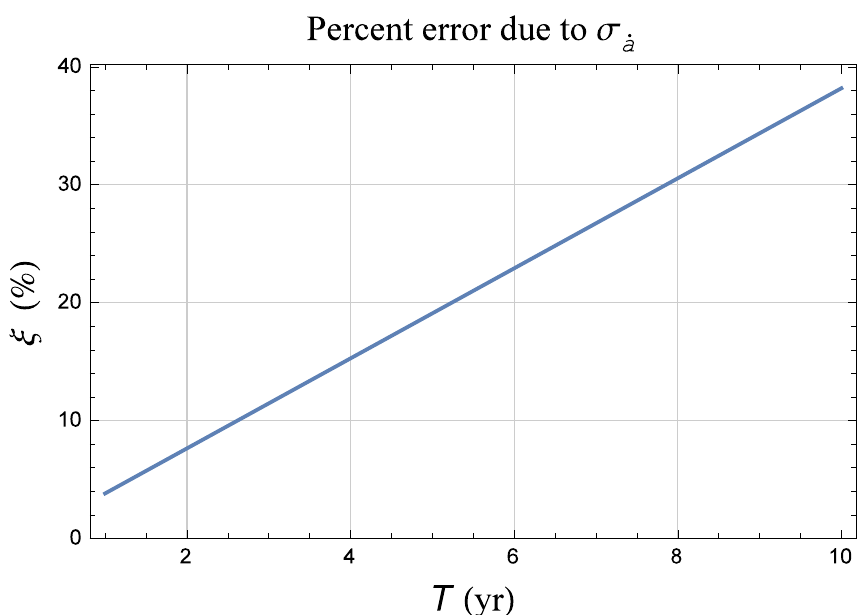
Figure A4. Percent systematic error ξ in the total L + CL Lense–Thirring node shift due to the uncertainties in the secular decays of the semimajor axes of L and CL calculated as a function of the data analysis time span T with Equations (22) and (23). For CL, we assumed ∆ a CL = 10 km, ∆ I CL = 0.15 deg, σ ˙ a CL = 0.01 m yr − 1 , while for L the value of the uncertainty in the decay of its semimajor axis adopted is σ ˙ a L = 0.035 m yr − 1 . In line with with what has been observed for the last decades in the case of LAGEOS, we assumed that σ ˙ a L σ ˙ a CL stay constant during T .